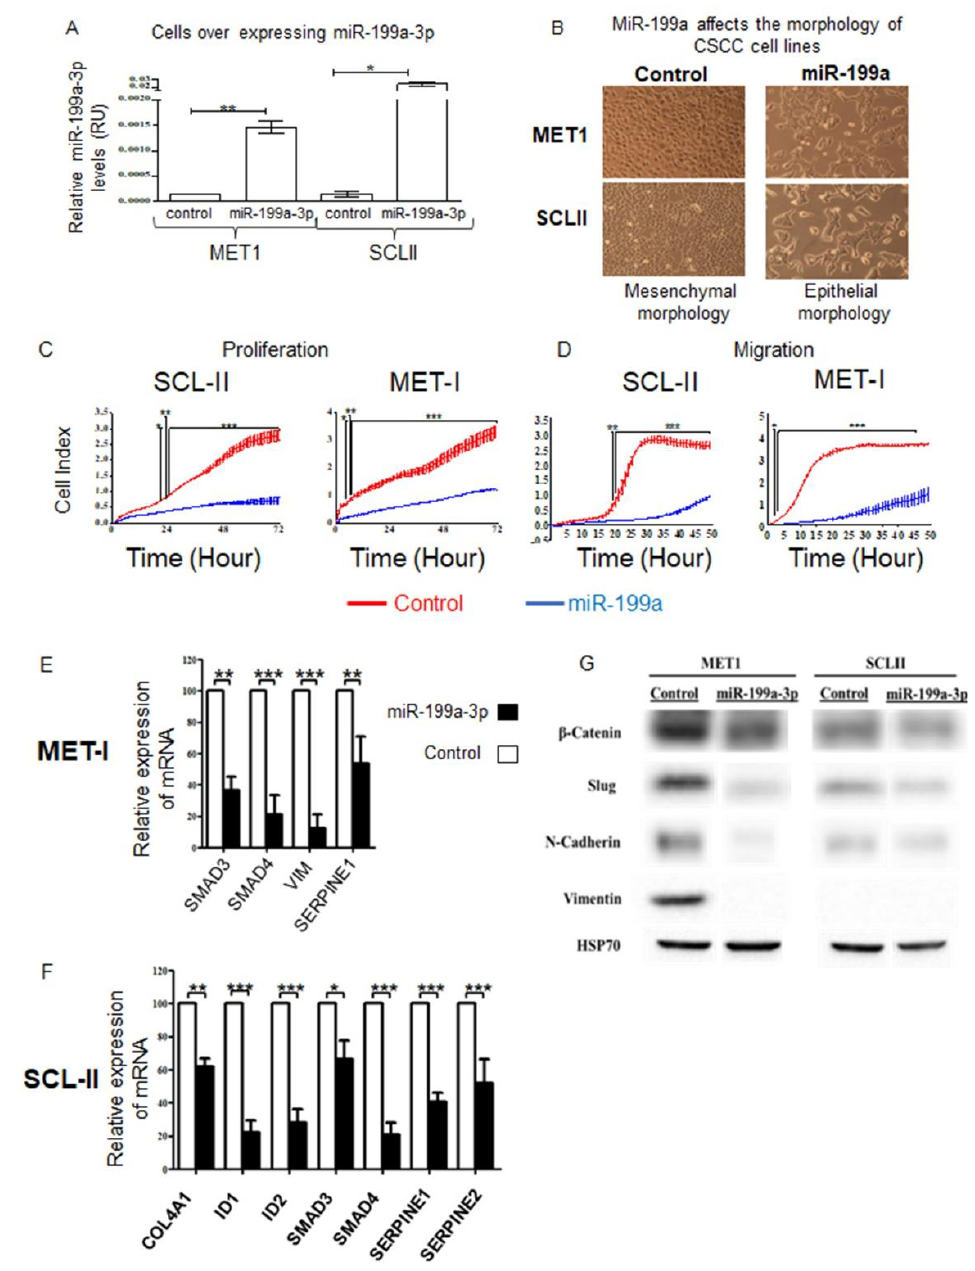
Figure 3. Phenotypic effects of miR-199a-3p on CSCC cells. ( A ) qRT-PCR analysis of miR-199a-3p normalized to Rnu43 in control or MET1 or SCL-II transfected with a plasmid expressing miR-199a-1. ( B ) Morphologic changes were consistent with MET in MET1 and SCL-II cells; the same number of cells was seeded initially in each sample. The photographs were taken under a phase-contrast microscope (magnification ×10). The growth ( C ) and migration ( D ) of MET1 and SCL-II cell-lines stably transfected with the control vector (red) or vector expressing mir-199a (blue) was assessed with xCELLigence TM real-time system. Statistics were performed using two-way ANOVA and Bonferroni post hoc corrections; * p < 0.05, ** p < 0.01, *** p < 0.001. The mRNA levels of EMT-related effectors in cells overexpressing miR-199a-3p. RNA extracts from ( E ) MET1 and ( F ) SCL-II cells were subjected to qRT-PCR with specific primers (see Methods). mRNA expression was calculated relative to RPLP0 expression. The expression of each mRNA, in cells overexpressing miR-199a-3p was relative to its expression in control cells. Values are expressed as the mean + SD of three independent experiments, * p < 0.05, ** p < 0.01, *** p < 0.001. ( G ) Protein extracts from the named cells were subjected to WB analysis with antibodies to the indicated proteins.